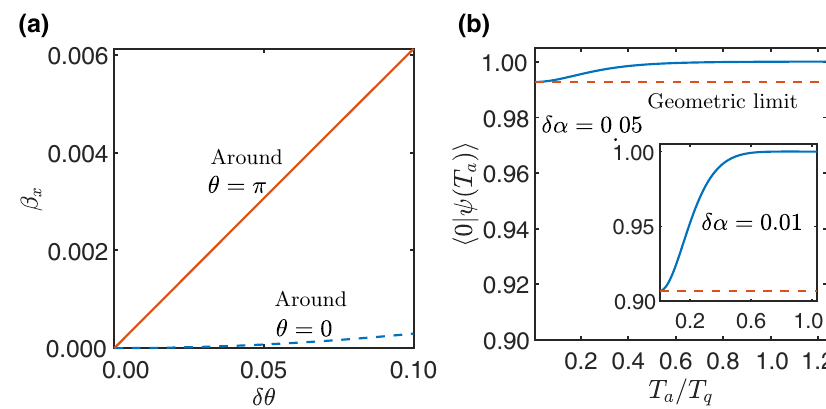
FIG. 6. (a) The Rabi oscillation strength β x in Eq. (7) as a function of the deviation δθ around θ = 0 (blue dashed line) and π (red solid line) for α 1 = 1.15, α 2 = 1.1, and R = 2.9. Note that for these parameters, t h /δα = 0.34. (b) The probability amplitude of the qubit initialized in state | 0 (cid:4) to remain in that state after time T a , (cid:16) 0 | ψ( T a ) (cid:4) , in terms of T q = (cid:2) /(cid:4) q for δα = 0.05 or t h /δα = 0.34 (in the inset, δα = 0.01 or t h /δα = 1.75). The blue curve is the result obtained from the full numerical implementation of the evolution, while the red-dashed line is (cid:16) 0 | ψ( T a ) (cid:4) evaluated in the geometrical limit using Eq. (E2). As T a is increased, the full curve starts to deviate from the geometric limit that is valid for T a (cid:6) T q and already almost reaches unity for T a ∼ T q , consistent with the adiabatic result. All plots are obtained using k F =